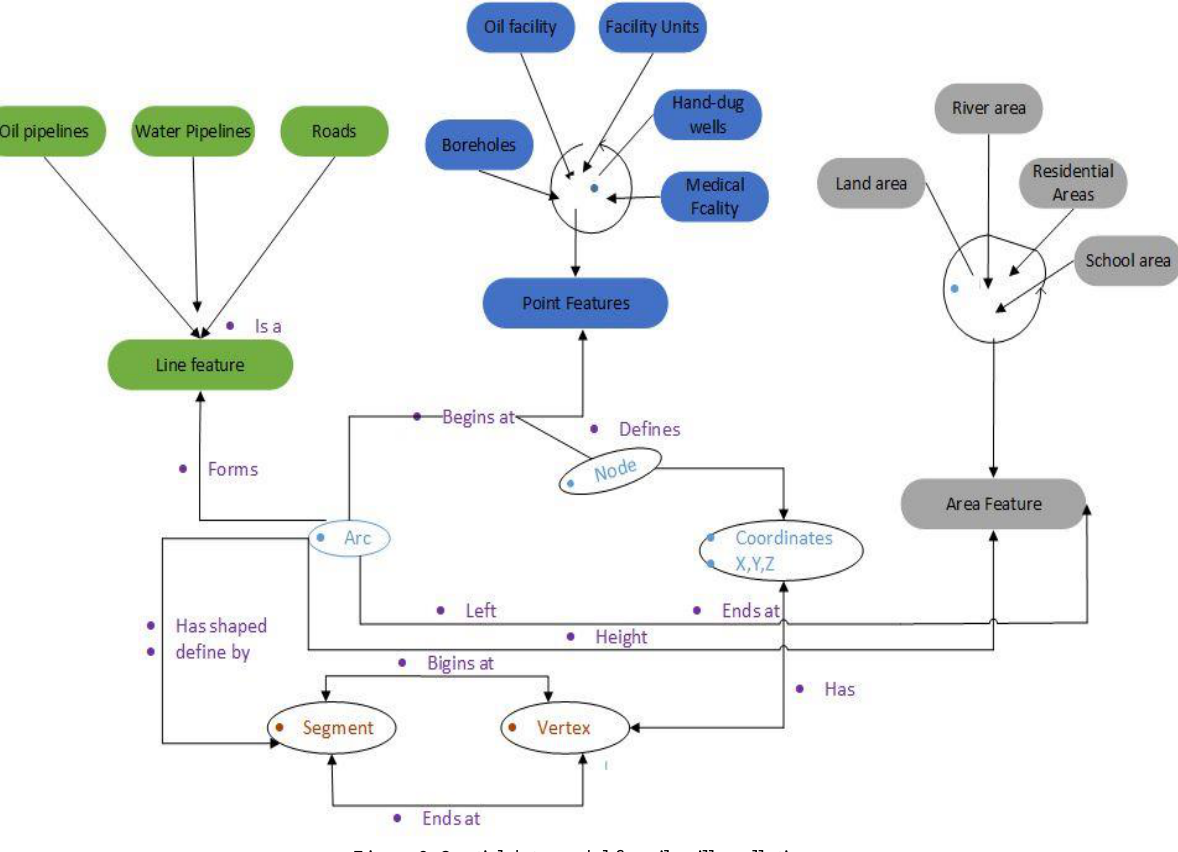
Figure 6. Spatial data model for oil spills